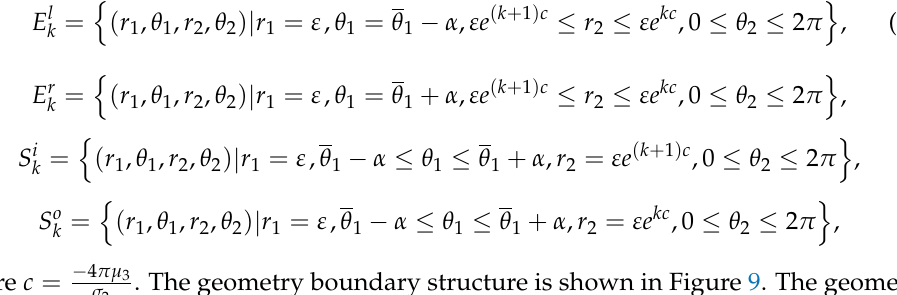
2 L P map in the 2